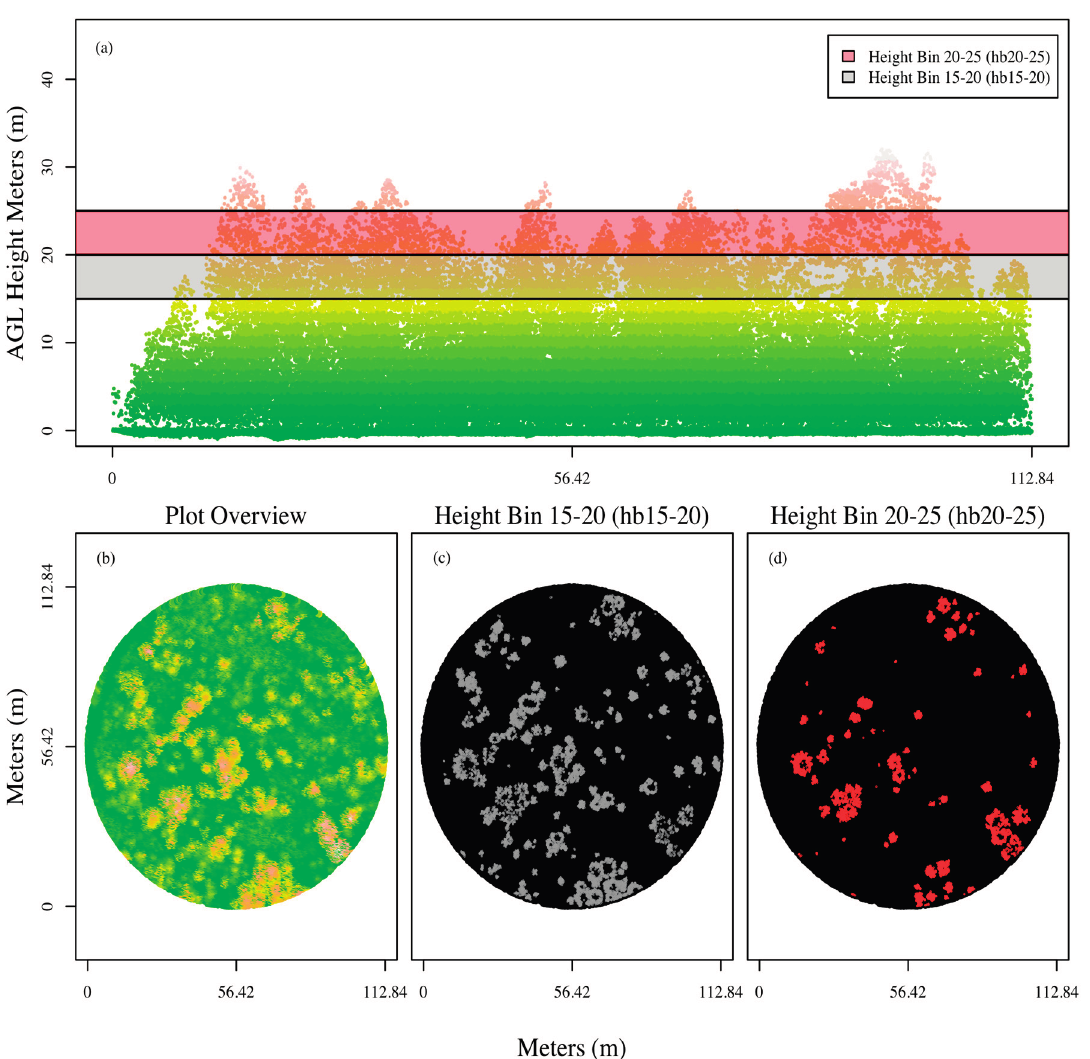
Figure 10. A visual comparison of height bin 15-20 and height bin 20-25 metrics for a hectare plot. Height bin15-20 provides more information about the conditions present on the hectare plot than height bin 20-25. ( a ) Cross sectional plot of one hectare plot and the location of height bin 15-20 and height bin 20-25; ( b ) Top-down representation of all points within the hectare plot; ( c ) Top-down representation of the points falling within height bin 15-20; and ( d ) Top-down representation of the points falling within height bin